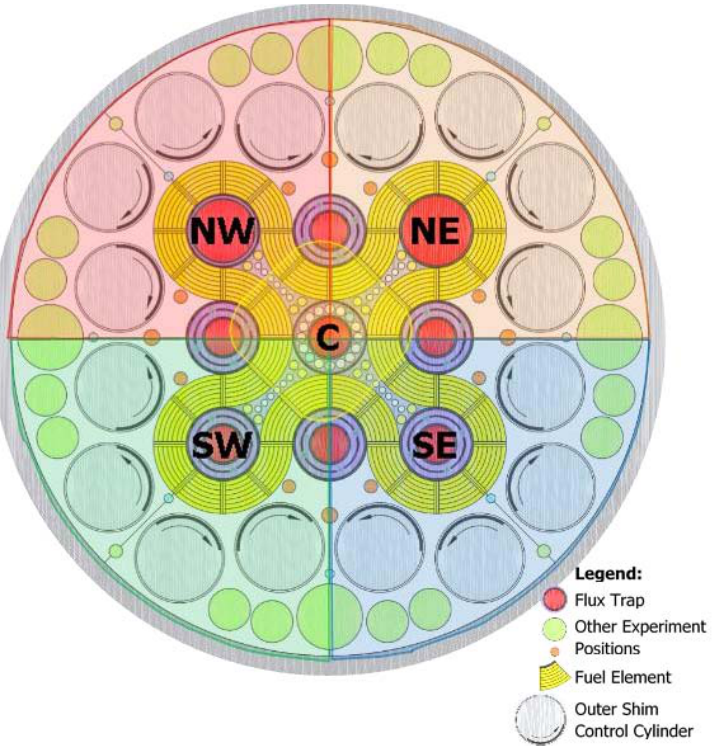
Figure 1. Plan View of ATR